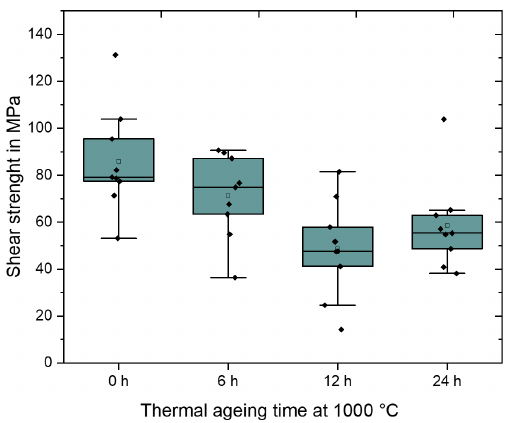
Figure 18. Influence of heat treatment on the shear strength. Glass- soldered chips under 0.55MPa pressure and sample size n =